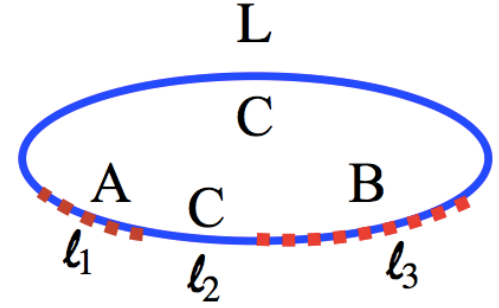
Figure 1 . Two disconnected regions in one di-